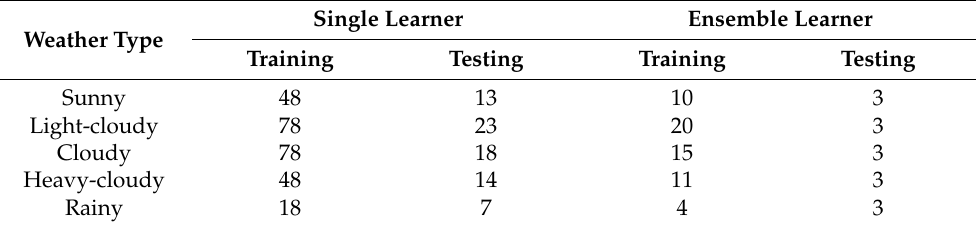
Table 2. The number of days in the training and testing stages. Weather Type